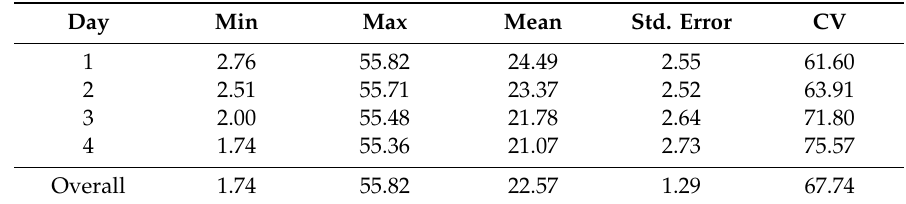
Table 2. Summary of descriptive statistics for chlorophyll measurements: minimum, maximum, mean, standard error and coe ffi cient of variation